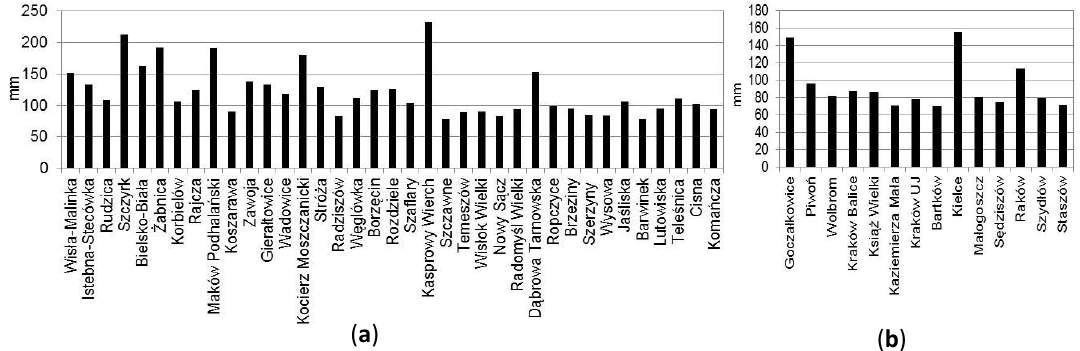
Figure 4. The annual maximum daily precipitation from 1971 to 2014 for the right-bank ( a ) and left-bank ( b ); Upper Vistula Basin.